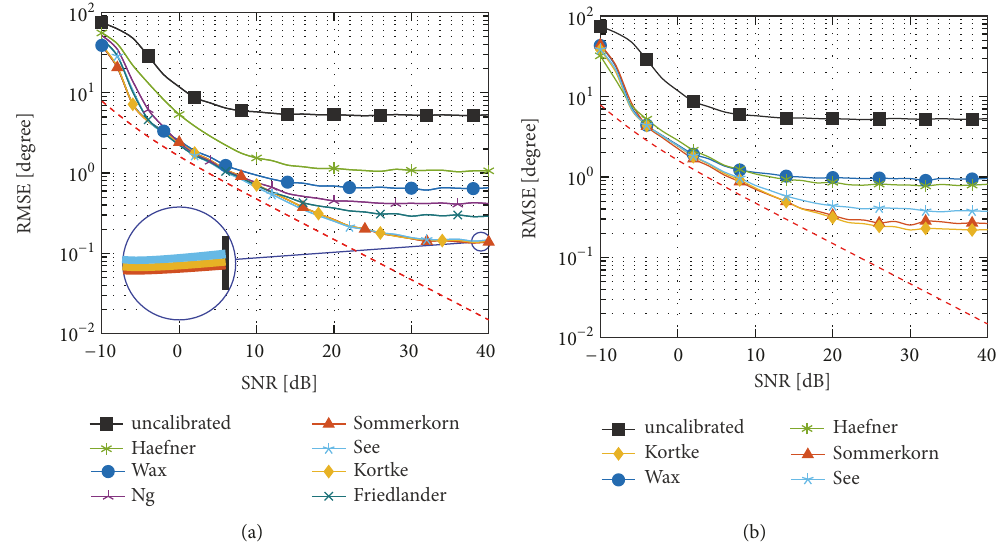
Figure 5: RMSE of AoA estimates with the ESPRIT algorithm and calibration w.r.t. (a) the element-space model and subsequent beam-space transformation and (b) the beam-space model. The CRLB is plotted as red dashed